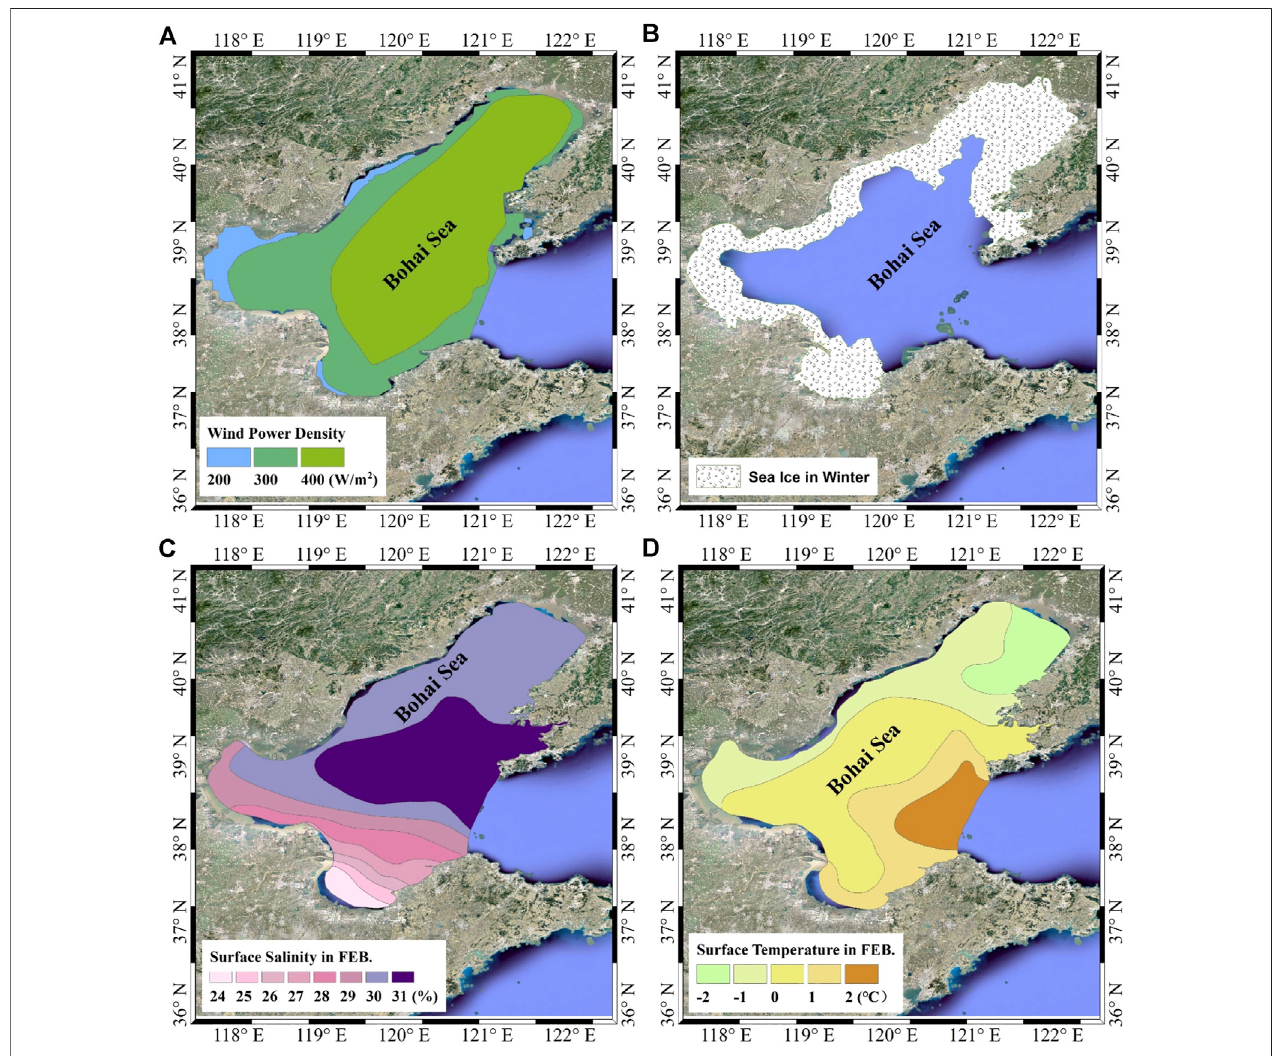
FIGURE1| Generalnatural environmental conditions inthe BohaiSea in winter. (A) The mean wind power density derived from thewind conditionsat 100 mfrom 1979 to 2013; (B) the sea ice distribution from a satellite image on 19 January 2022; (C) the surface salinity distribution in February; (D) the surface temperature distribution in